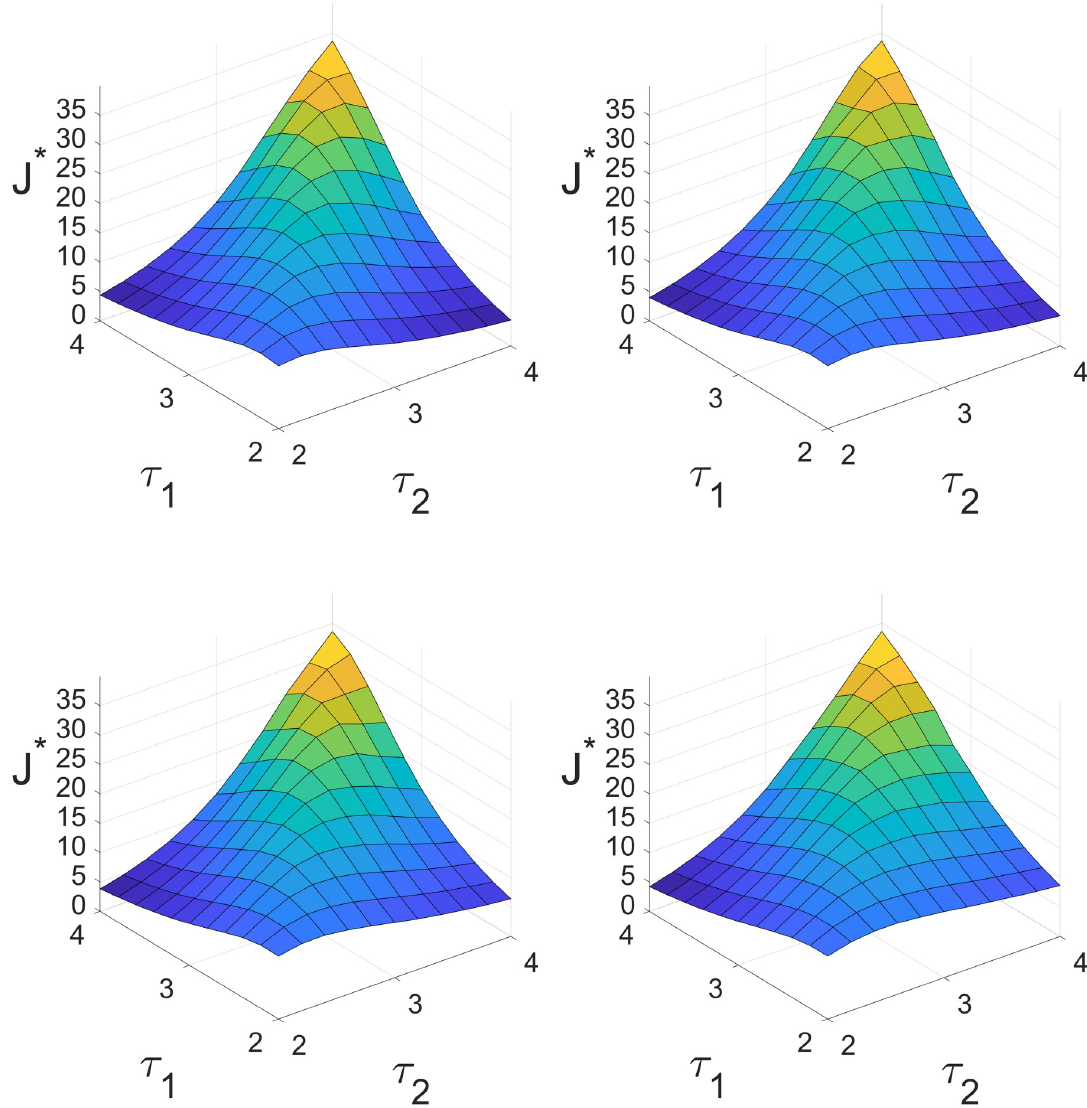
Fig 6. The oscillation propensity J � for Θ = 0.5 minutes as a function of the delays τ 1 and τ 2 in the range [2, 4] minutes, VSM corresponding to p = 0.5 and q = 0.5 (top left), p = 0.4 and q = 0.6 (top right), p = 0.3 and q = 0.7 (bottom left), p = 0.2 and q = 0.8 (bottom